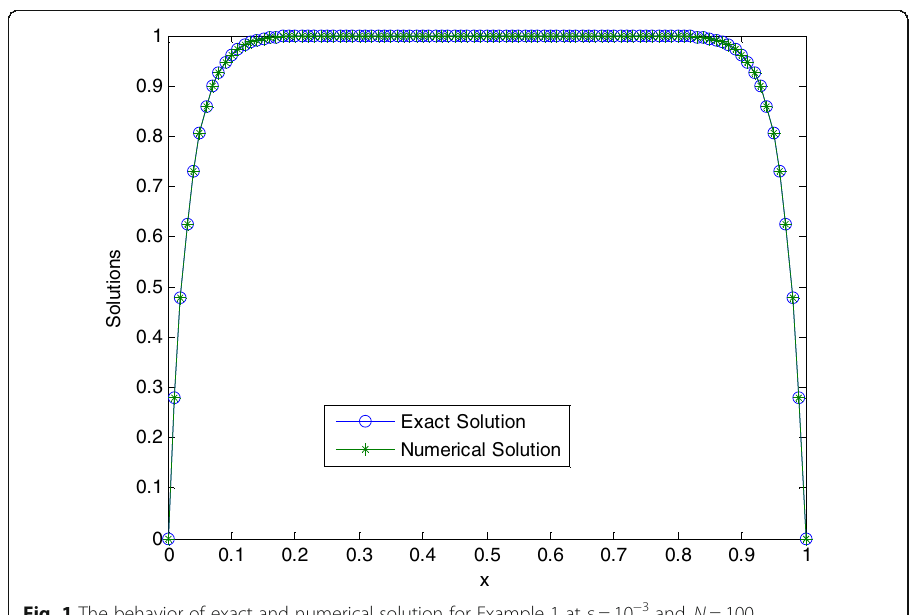
Fig. 1 The behavior of exact and numerical solution for Example 1 at ε = 10 − 3 and N = 100